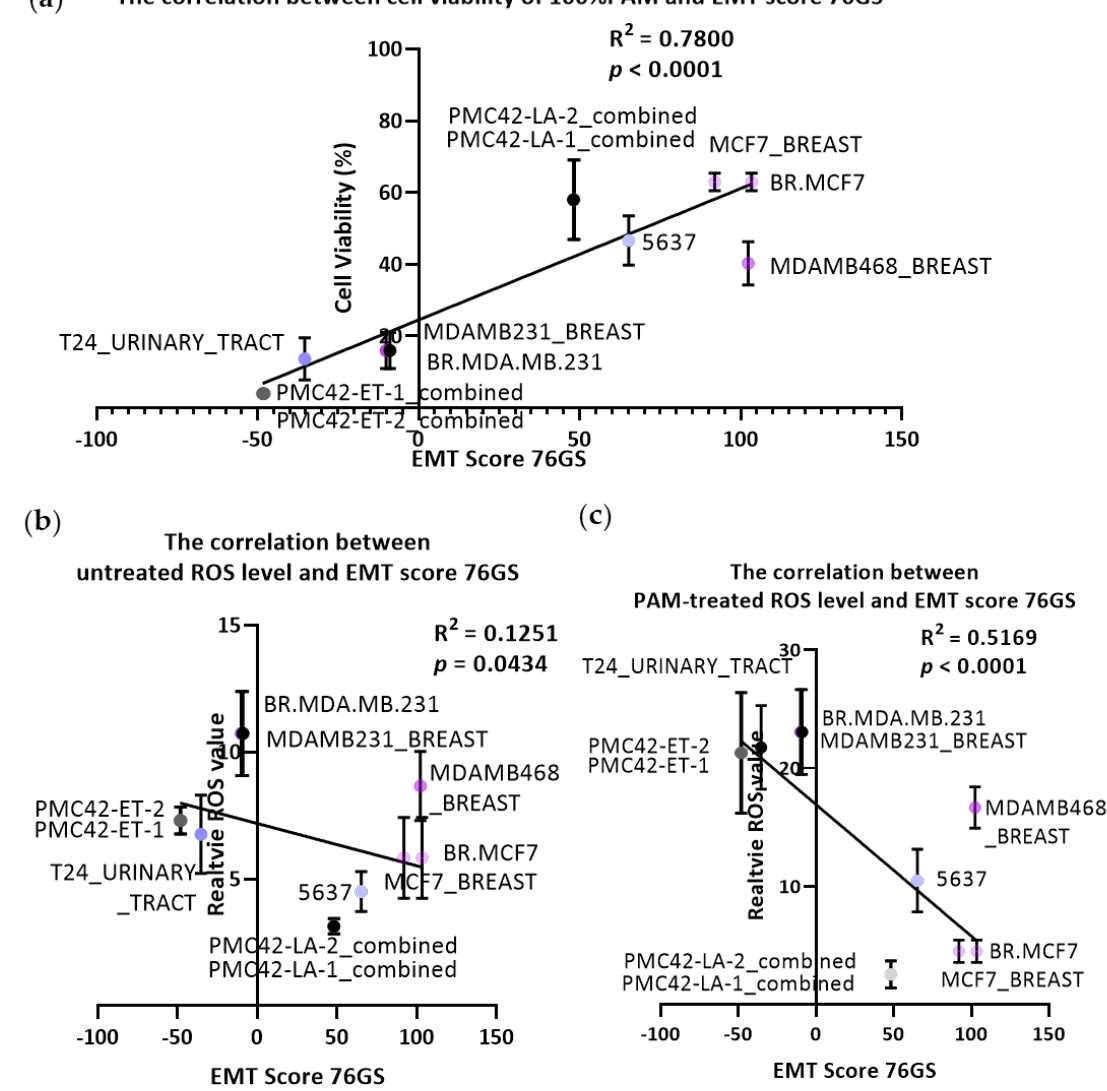
Figure 3. Transcriptomally derived EMT scores correlate with PAM response. ( a ) Correlation between cell viability following 12 h 100% 10PAM treatment and EMT score 76GS for MCF-7, MDA-MB-468, MDA-MB-231, PMC42-LA, PMC42-ET, 5637, and TSU-Pr1 (T24). In some cases, scores were derived using data for the same cell line from different public repositories (e.g., CCLE: BR.MCF7, BR.MDA.MB.231; NCI60: MCF7_BREAST, MDAMB231_BREAST). ( b ) Correlation between untreated (baseline) cellular ROS levels and EMT score 76GS. ( c ) Correlation between PAM-treated cellular ROS levels and EMT score 76GS.